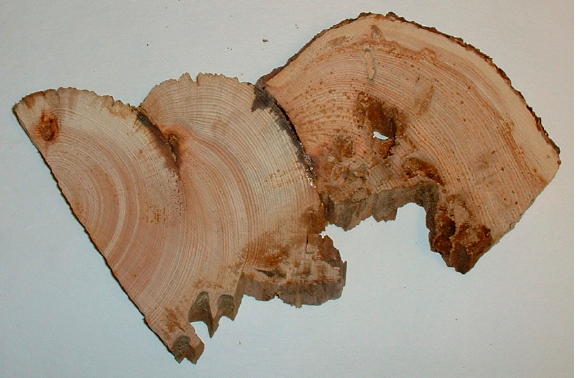
Figure 2. A partial cross-section from a whitebark pine tree with two fire scars extracted using